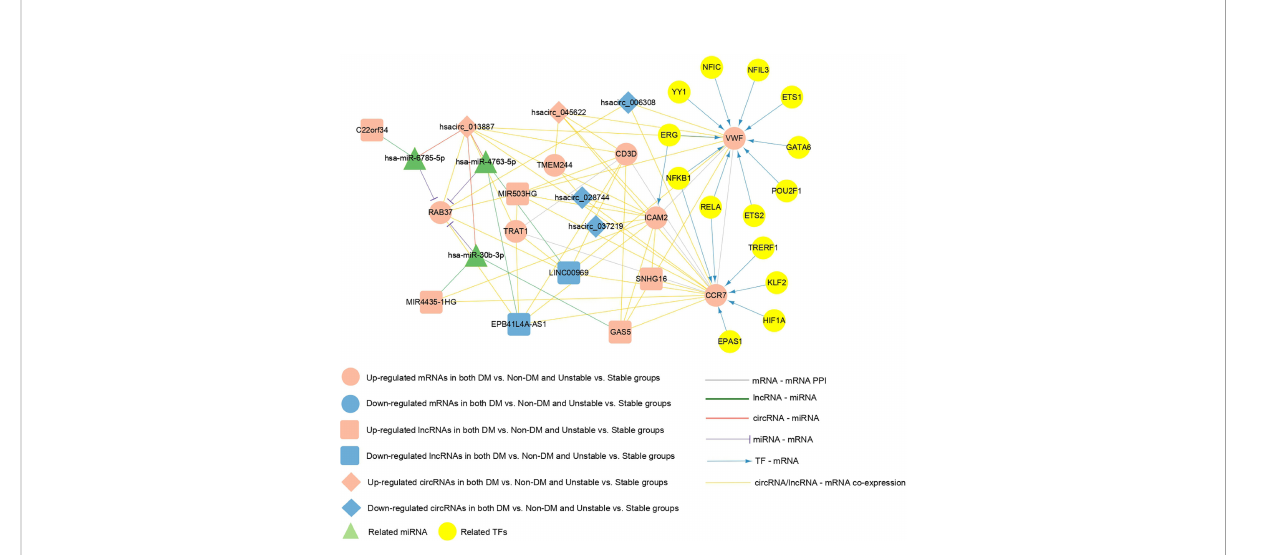
FIGURE 8 The comprehensive network of important overlapping genes. Red and blue represent the RNAs that are signi fi cantly upregulated and downregulated, respectively, in the two comparison groups. Circles, diamonds, and squares represent mRNAs, circRNAs, and lncRNAs, respectively, green triangles represent related miRNAs, and yellow circles represent TFs. Grey lines indicate an interaction connection. Green, red, and purple line respectively indicate lncRNA-miRNA, circRNA-miRNA, and miRNA- mRNA connections. Blue lines indicate TF-mRNA connections, and yellow lines indicate circRNA/lncRNA-mRNA co-expression